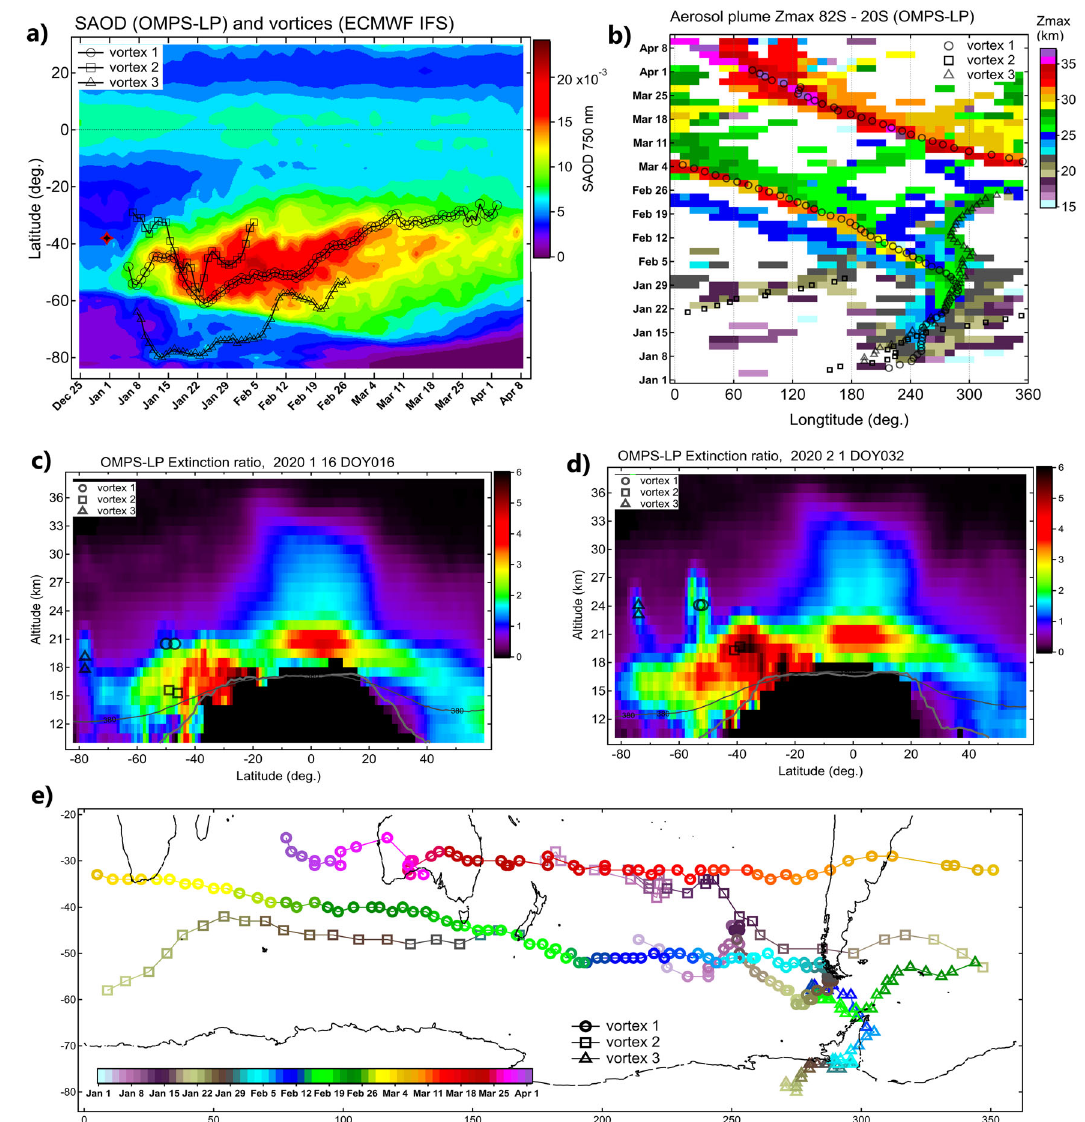
Fig. 10 Three-dimensional evolution of the three vortices from OMPS-LP and ECMWF IFS. a Time-latitude section of zonal-mean stratospheric aerosol optical depth (above the tropopause) from OMPS-LP measurements. The markers show locations of smoke-charged vortices identi fi ed using ECMWF vorticity fi elds. b Longitude-temporal evolution (Hovmöller diagram) of the maximum altitude of smoke plume inferred from OMPS-LP extinction data within 30 °S – 60° above 15 km where aerosol to molecular extinction ratio exceeds 5. The markers indicate the locations of the smoke-charged vortices identi fi ed using ECMWF vorticity fi elds. c Latitude – altitude section of zonal-mean aerosol to molecular extinction ratio above the local tropopause from OMPS-LP measurements for 16 January 2020. The thick and the thin curves indicate, respectfully, the zonal-mean lapse-rate tropopause and the 380 K potential temperature level. The markers show the positions of the main vortex and of the two companion vortices. d Same as ( c ) for 1 February 2020. e Trajectories of the three vortices with colour-coded date in the longitude-latitude